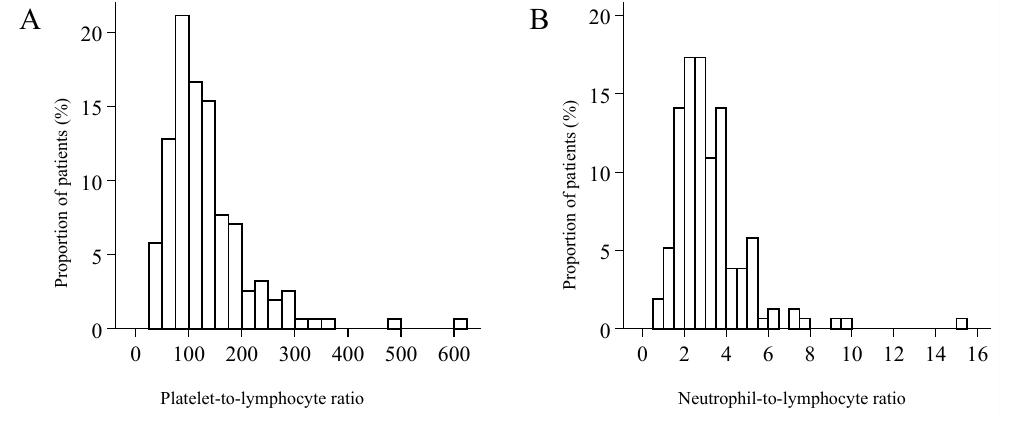
Figure 2. The distribution of the platelet-to-lymphocyte ratio ( A ), and of the neutrophil-to-lymphocyte ratio ( B ).